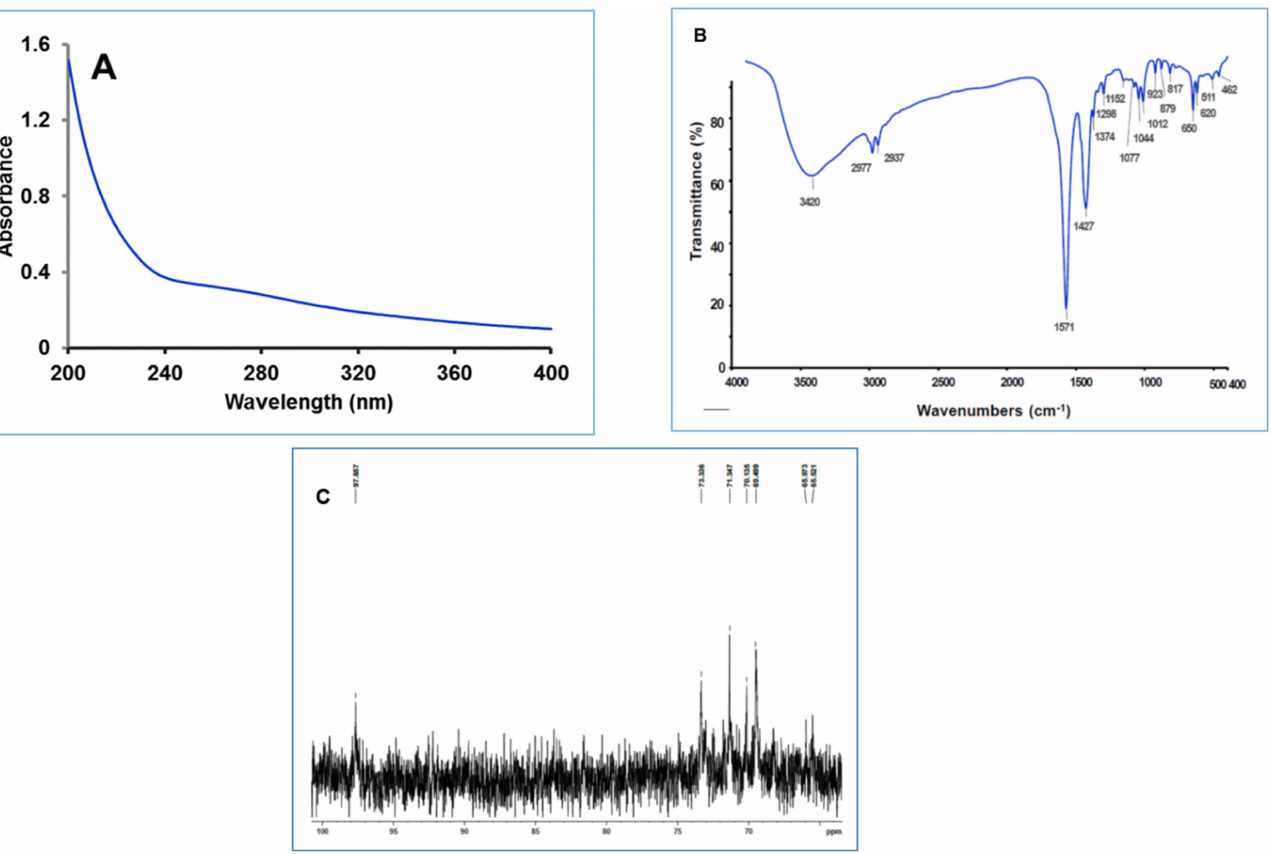
Figure 1. UV spectra of CICP ( A ); FTIR spectra of CICP ( B ); 13 C spectra of CICP ( C